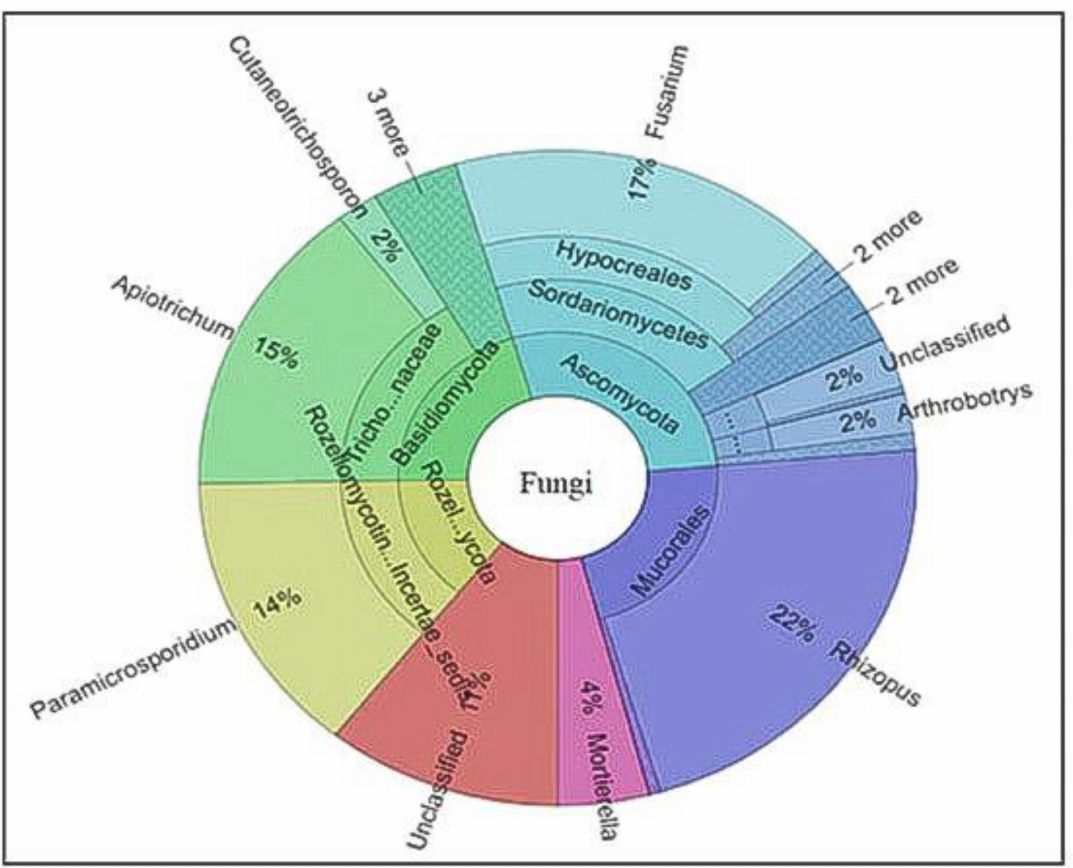
Figure 11. A Krona chart representing the whole fungalcommunity distribution in compost sample